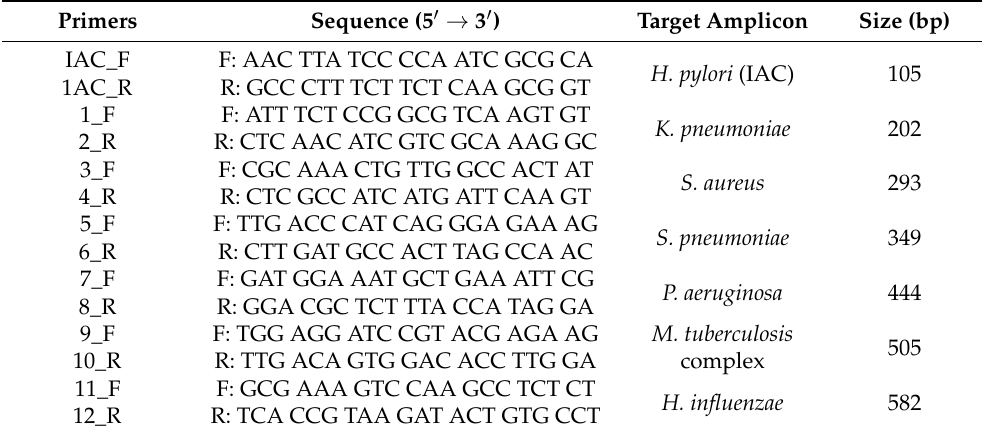
Table 1. Characteristics of the primers used for the development of heptaplex PCR